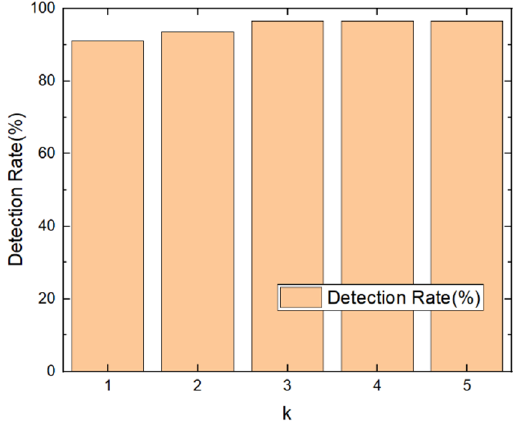
Figure 9. Attention Filtering Results.